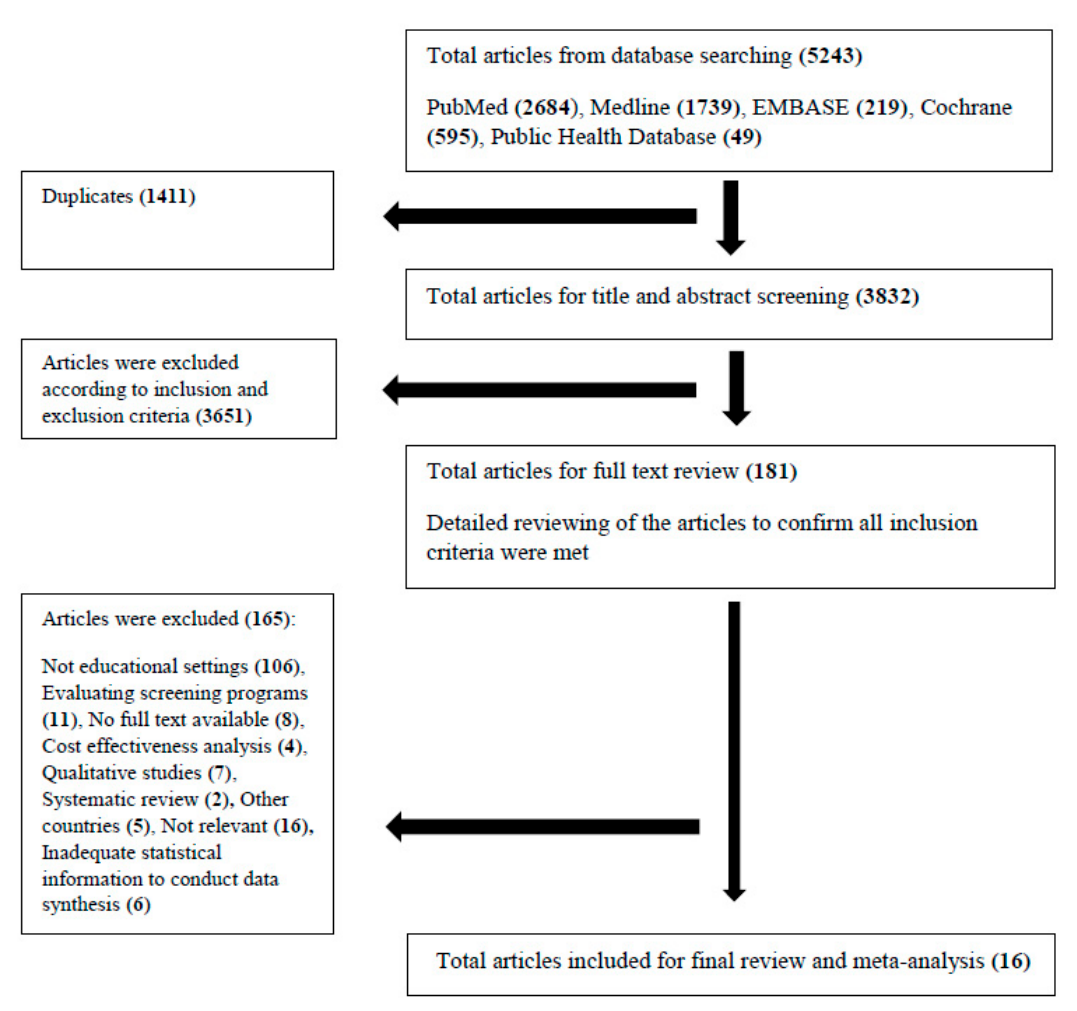
Figure 1. PRISMA flow diagram for included studies.